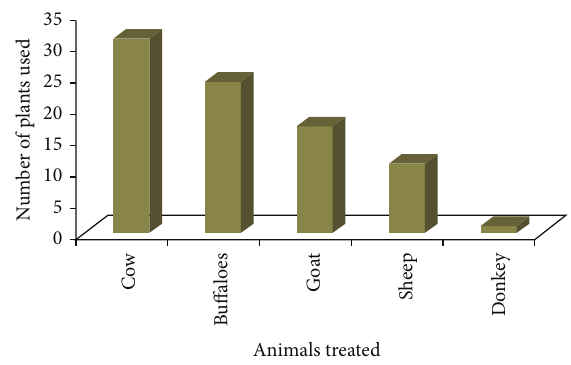
Figure 2: Number of plants used to treat different domestic animals.